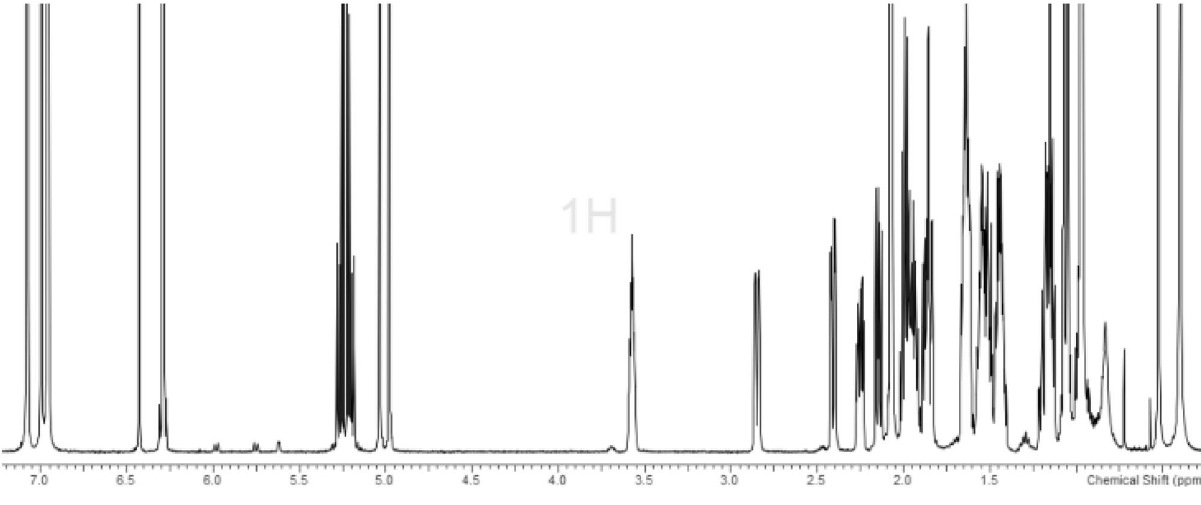
Figure 5. 1 H NMR spectrum of 1 in toluene-d 8